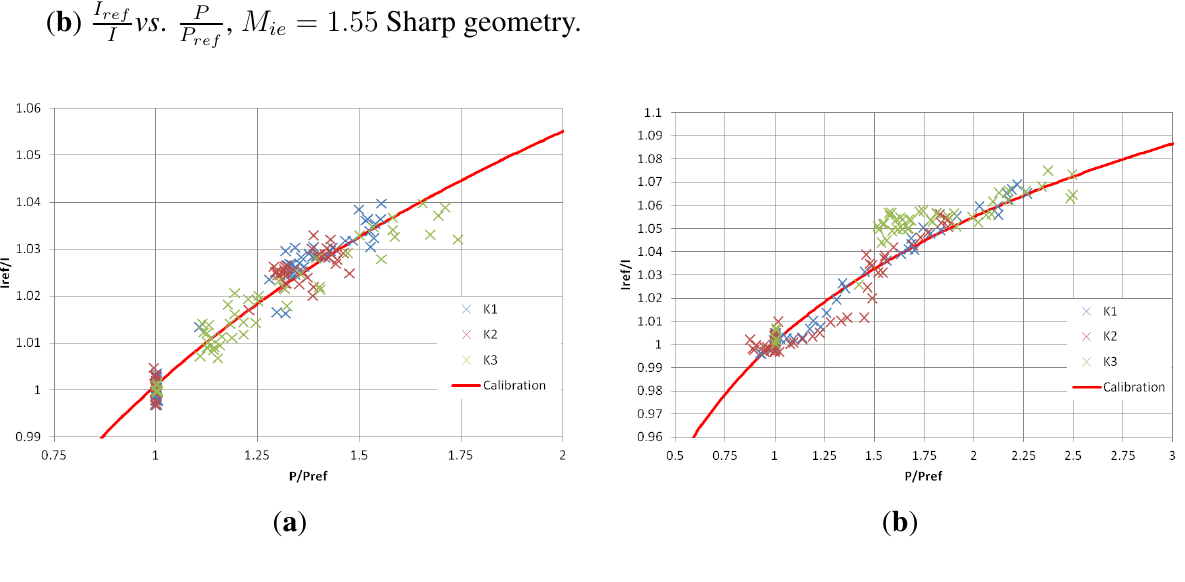
Figure 7. In situ calibration of PSP samples. ( a ) I ref vs . P ( b ) I ref , M = 1 . 55 Sharp ie I P ref